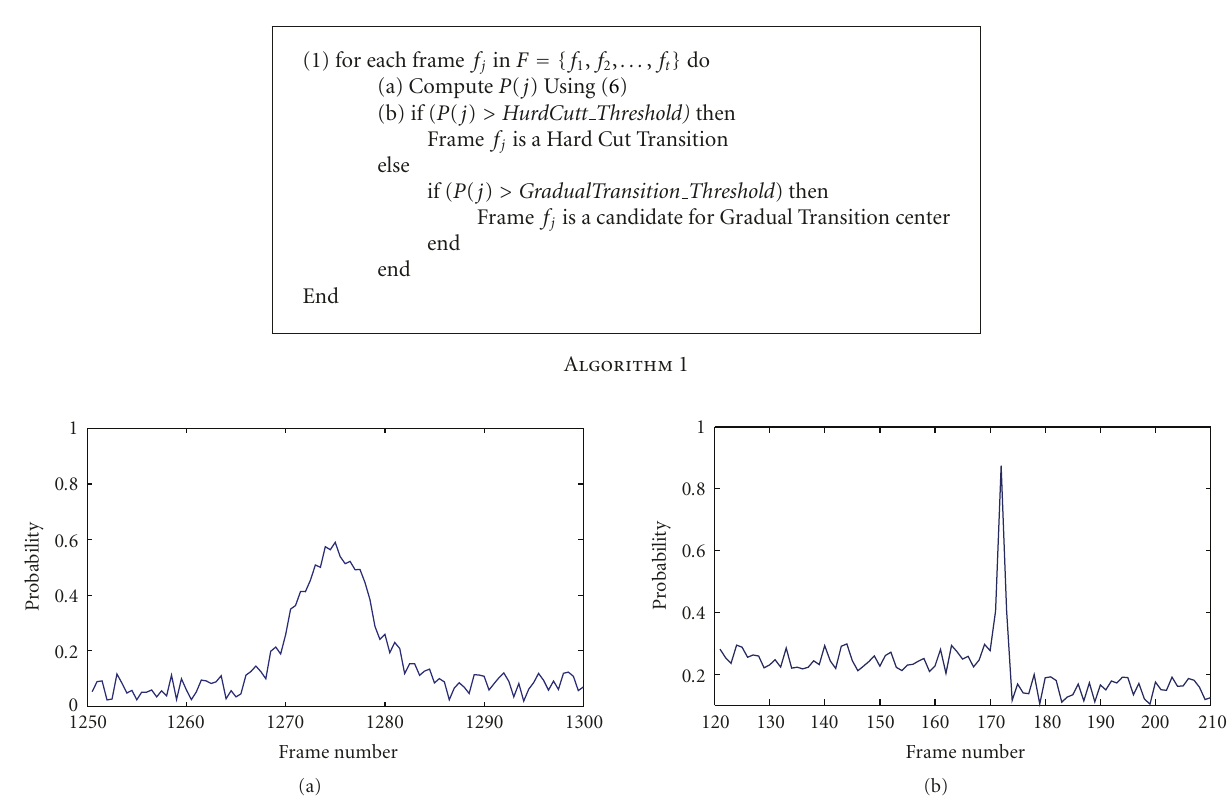
Figure 1: The probability function of (6). (a) For a gradual transition which is semi-Gaussian and (b) for a hard cut transition.